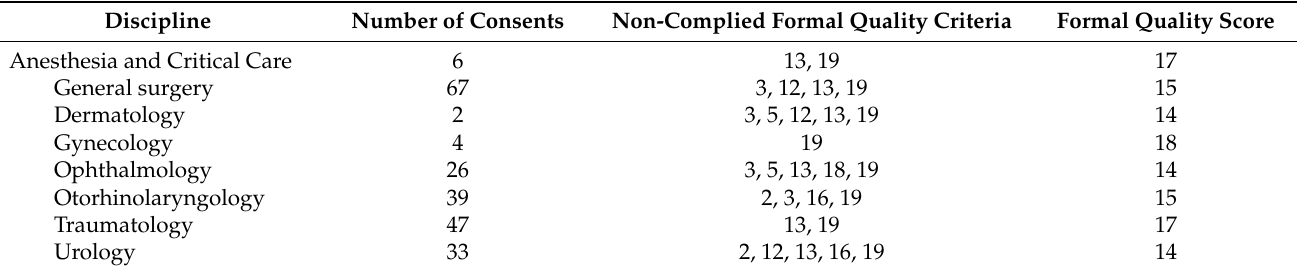
Table 3. Formal quality of the surgical consent forms of the hospital.